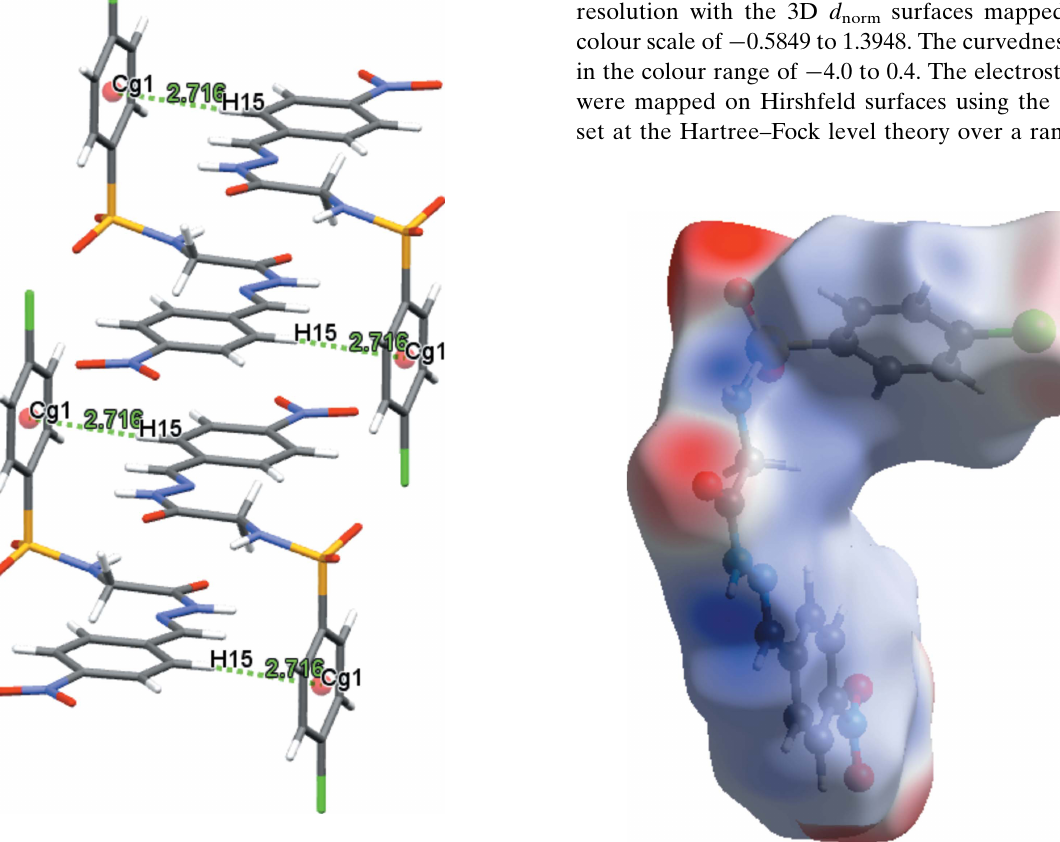
Figure 6 View of the Hirshfeld surface mapped over the electrostatic